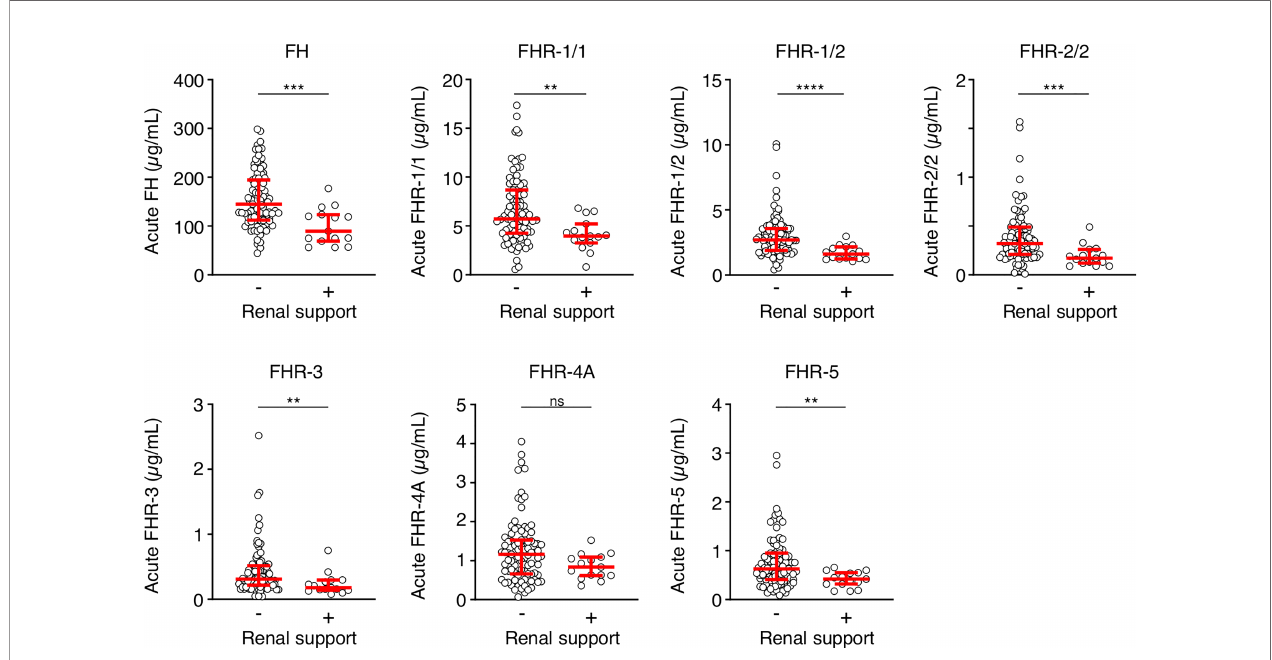
FIGURE 5 | FH family proteins are low in patients who receive renal support. Serum levels of FH, FHR-1/1, FHR-1/2, FHR-2/2, FHR-3, FHR-4A and FHR-5 at the acute stage of patients who did ( n = 15) or did not ( n = 90) receive renal support. Both surviving and non-surviving patients are included here. Statistical signi fi cance was tested using a Mann-Whitney test. Lines depict median and IQR. **** p < 0.0001; *** p < 0.001; ** p < 0.01; ns, not signi fi